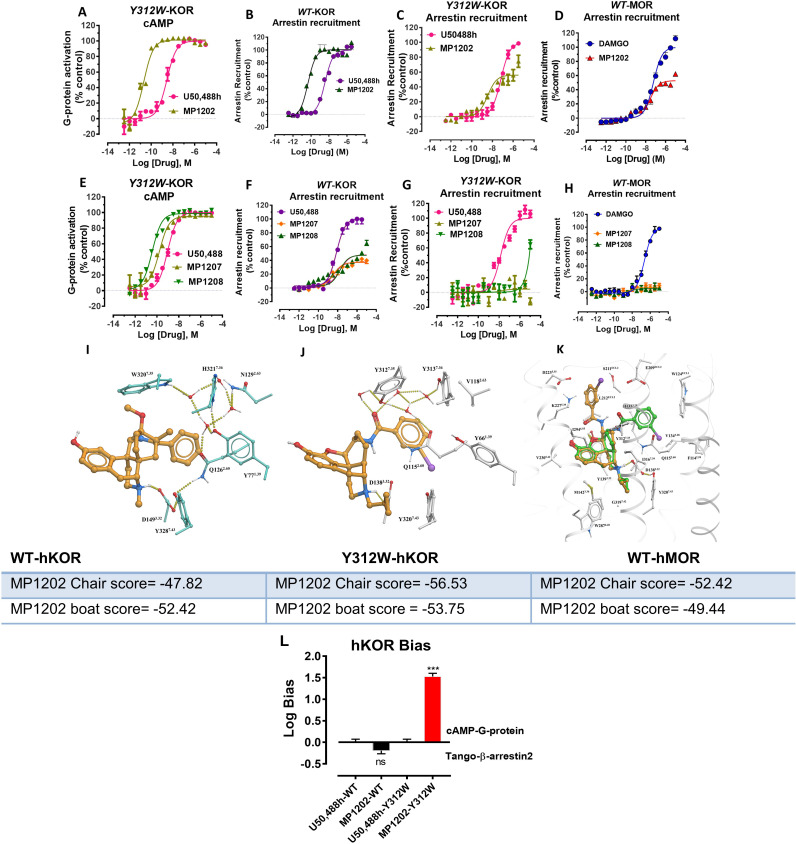
Mutation of KOR Y312W leads to a receptor mimicking MOR arrestin recruitment.MP1202 flips to a G protein biased agonist and arrestin recruitment for MP1207 and MP1208 is reduced. (A and C) At Y312W-hKOR, MP1202 (light green) is a G-biased agonist in cAMP inhibition (N = 3) (A) and Tango-arrestin recruitment assays (N = 3) (C) compared to U50,488H (pink). (B) At WT-hKOR, MP1202 (purple) acts as a full agonist for arrestin recruitment (N = 3). (D) At WT-hMOR, MP1202 (red) acts as a partial agonist for arrestin recruitment (N = 3). (E and G) At Y312W-hKOR, MP1207 (light green) and 1208 (dark green) show full agonism in cAMP inhibition (N = 3) (E) and reduced arrestin measurement in Tango-arrestin recruitment assays (N = 3) (G) compared to U50,488H (pink). (F) At WT-KOR, MP1207 (orange) and MP1208 (green) act as partial agonists for arrestin recruitment (N = 3) compared to control U50,488H (purple). (H) At WT-MOR, no arrestin recruitment (N = 3) was observed for both agonists MP1207 and MP1208. (I) Conformation of selected residues seen in high resolution active state MOR structure along with crystallographic waters around TM2-TM3 region and crystallized ligand (BU72). MOR, conformation of conserved Q2.60 is maintained by a rather extensive hydrogen-bonding network mediated by W7.35 and at least four tightly bound waters as found in the crystal structure. (J) Conformation of selected residues and MP1202 seen in active state KOR structure, along with modeled waters around TM2-TM3 region. In KOR, no crystallographic waters were resolved in the structure, the non-conserved residues, including Y7.35 instead of W7.35, would rearrange water network and change conformation of Q2.60, paramount for ligand binding. A theoretical water network was modeled using SampleFlood method of ICM Molsoft in the orthosteric ligand site, and resulting waters were optimized via several rounds of extensive conformational sampling. As a result of significant difference observed in the water network, compared to MOR, KOR’s Q1152.60 moves further inwards and is positioned between D1383.32 and Y3127.43, and this new position of Q1152.60 is stabilized via a water-mediated hydrogen bond with Y3127.35. (K) Docking poses of chair and boat conformations of MP1202 in Y312W KOR mutant. The chair form (−56.53) is favored over boat form (−53.75) at this mutant receptor for MP1202. (L) Bias plots for U50,488h and MP1202 at hKOR and Y312W hKOR mutant. MP1202 is not significantly different from U50,488h with respect bias for G over βarrestin-2 signaling at wild type receptor while at the hKOR mutant it shows G-biased signaling. Data are mean± SEM from N = 3 replicates. Data analyzed using unpaired t-test with Welch’s correction,***p=0.0001. See Appendix 1—table 9 for values, Appendix 1—figure 4 and Appendix 1—table 10 for bias calculations.